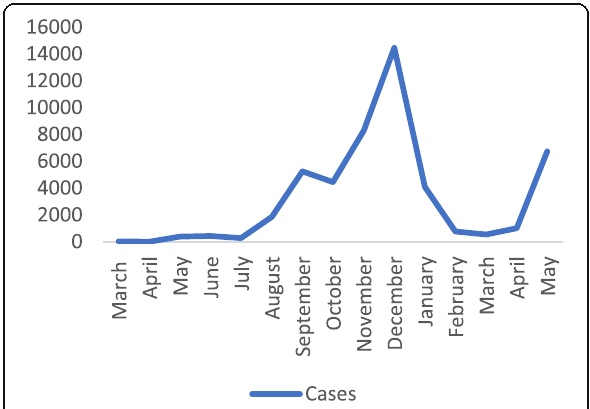
Fig. 1 Number of COVID-19 cases from March 2020 to May 2021 as reported by the Ministry of Health in Uganda